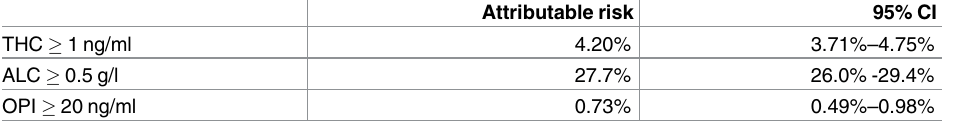
Table 5. Risk risks attributable * to driving under the influence (n = 4,047 ** .data source Voiesur 2011, fatal